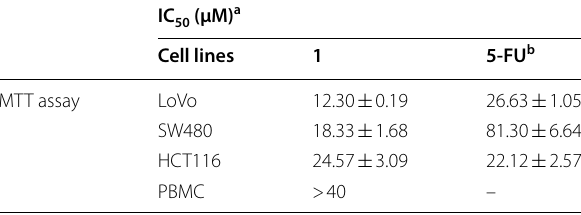
Table 2 Cytotoxicity of compound 1